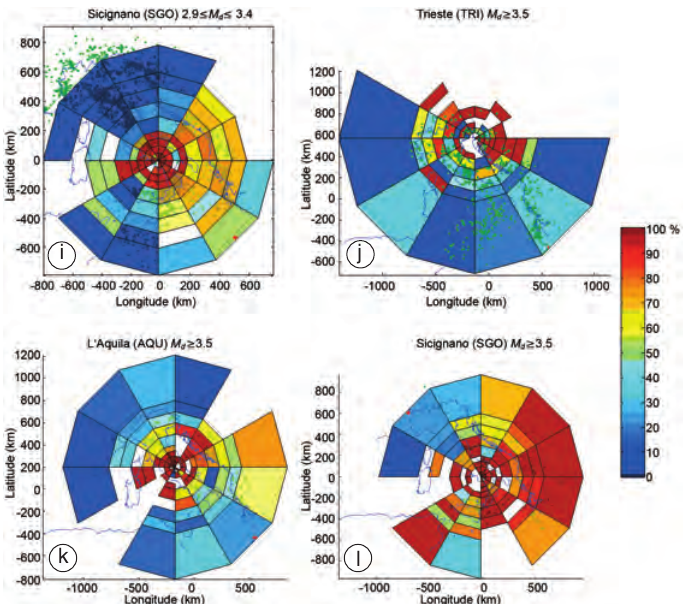
Fig. 15i-l. i) Percentage of events (2.9 ≤ M d ≤ 3.4) detected by Sicignano station. j) Percentage of events ( M d ≥ ≥ 3.5) detected by L’Aquila station. l) Percentage ≥ 3.5) detected by Trieste station. k) Percentage of events ( M d of events ( M d ≥ 3.5) detected by Sicignano station. The criteria are explained in fig. 14. Green dots are the events recorded by the RSNC network in the range of duration magnitude